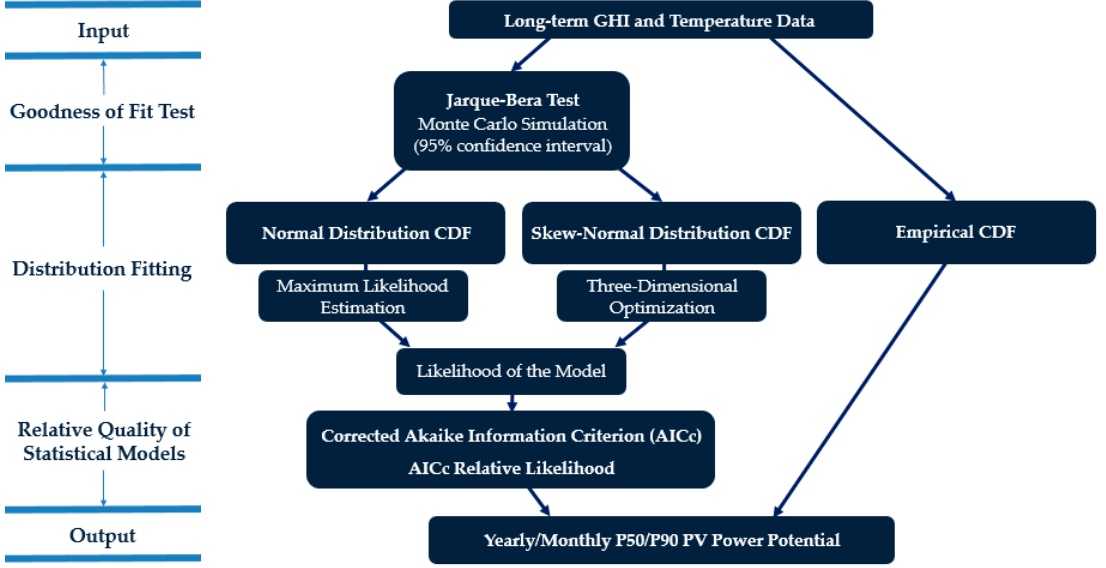
/ P90 photovoltaic (PV) power potential. Figure 4. Flowchart of P50/P90 photovoltaic (PV) power potential. Figure 4. Flowchart of P50